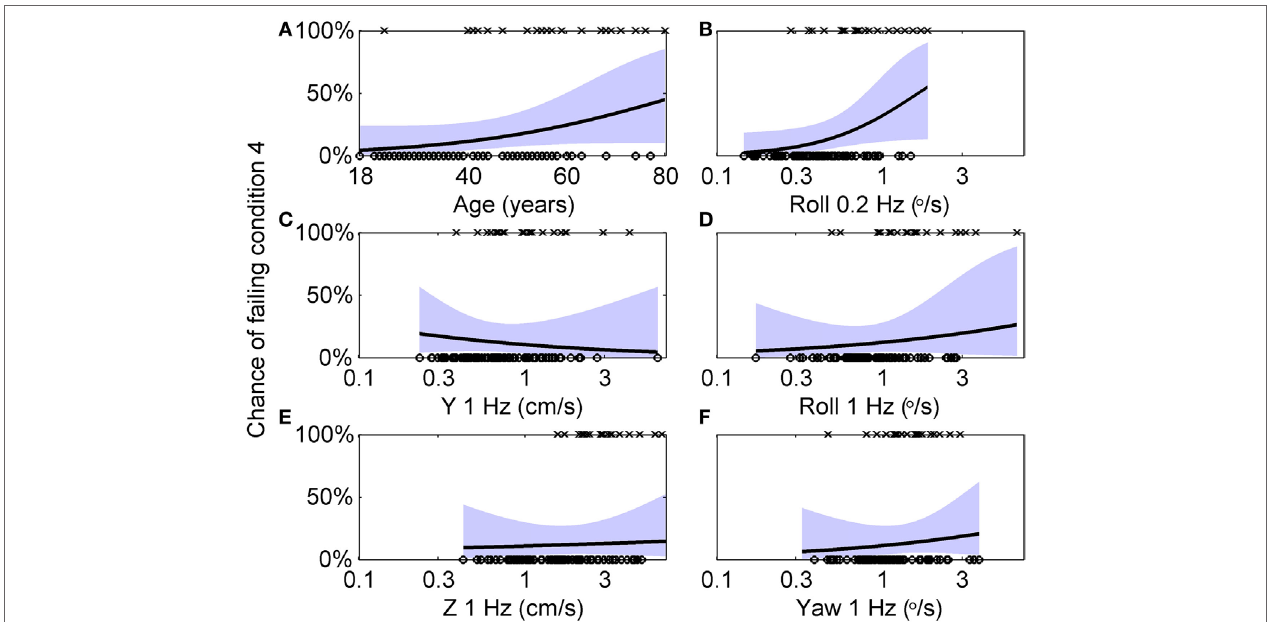
FigUre 5 | Logistic regression curves showing the dependency of failing condition 4 on age and each threshold measure. (a) Circles ( ○ ) indicate individual subjects who passed condition 4, while crosses ( × ) indicate subjects who failed condition 4. A logistic curve showing the dependency of the chance of failing condition 4 on age, with the shaded area showing the 95% confidence intervals. Each curve is generated by holding the other five variables at the median value of their sample, so it does not show the combined influence of multiple variables. (B–F) Similar analyses for each of the five threshold measurements.